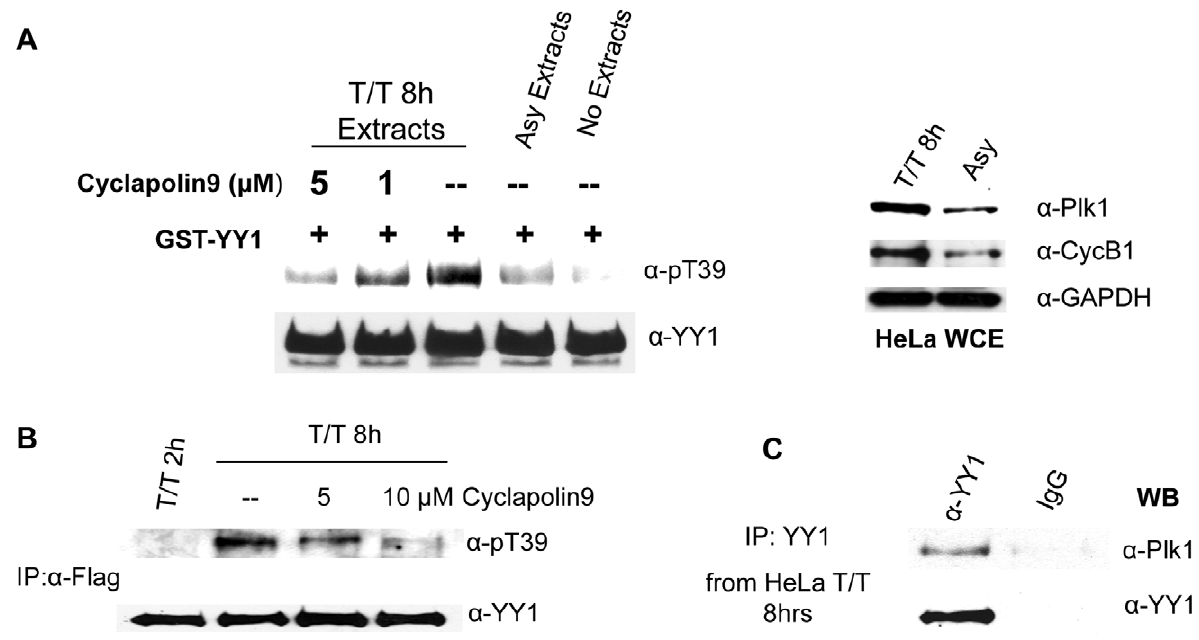
Figure 7. Plk1 phosphorylates YY1 at threonine 39 invivo . ( A ) Western blot analysis of cold in vitro kinase assay reactions using HeLa whole cell extracts (WCE) as the source for kinase activity and bacterially expressed GST-YY1 bound to glutathione beads, as substrate. WCEs were prepared from HeLa cells, asynchronously growing or double-thymidine blocked and released for eight hours (T/T 8 h). Plk1 inhibitor, Cyclapolin 9, was added to the kinase reactions of T/T 8 h extracts at the indicated concentrations. Reactions were separated on SDS-PAGE, transferred to nitrocellulose membrane, and probed with anti-pT39, then anti-YY1 antibody. WCEs were also analyzed on a separate Western blot (right panel), using anti-Plk1 and anti-Cyclin B1 antibodies. Anti-GAPDH was used as a loading control. ( B ) Flag-YY1 was immunoprecipitated from HeLa-Flag-YY1 cells, synchronized by double-thymidine block and released for eight hours. Cyclapolin 9 (or DMSO, for the negative control for the inhibitor) was added to the cells four hours prior to cell collection. Flag-YY1 was also immunoprecipitated from cell extracts collected two hours after release as a negative control. The resulting Western blot was probed with anti-pT39 and anti-YY1 antibodies. ( C ) Co-immunoprecipitation of Plk1 with YY1 from WCEs prepared from HeLa cells released for eight hours after double thymidine block. YY1 was immunoprecipitated using an antibody specific for the last 20 amino acids of the YY1 (C-20). IgG was used as a control for the specificity of the immunoprecipitation. The Western blot was probed with anti- Plk1 and then anti-YY1 antibodies.